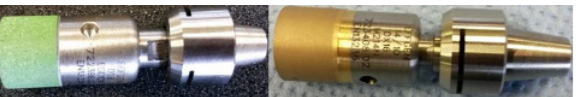
Fig. 1. Resin bonded tool(left) and metal bonded tool